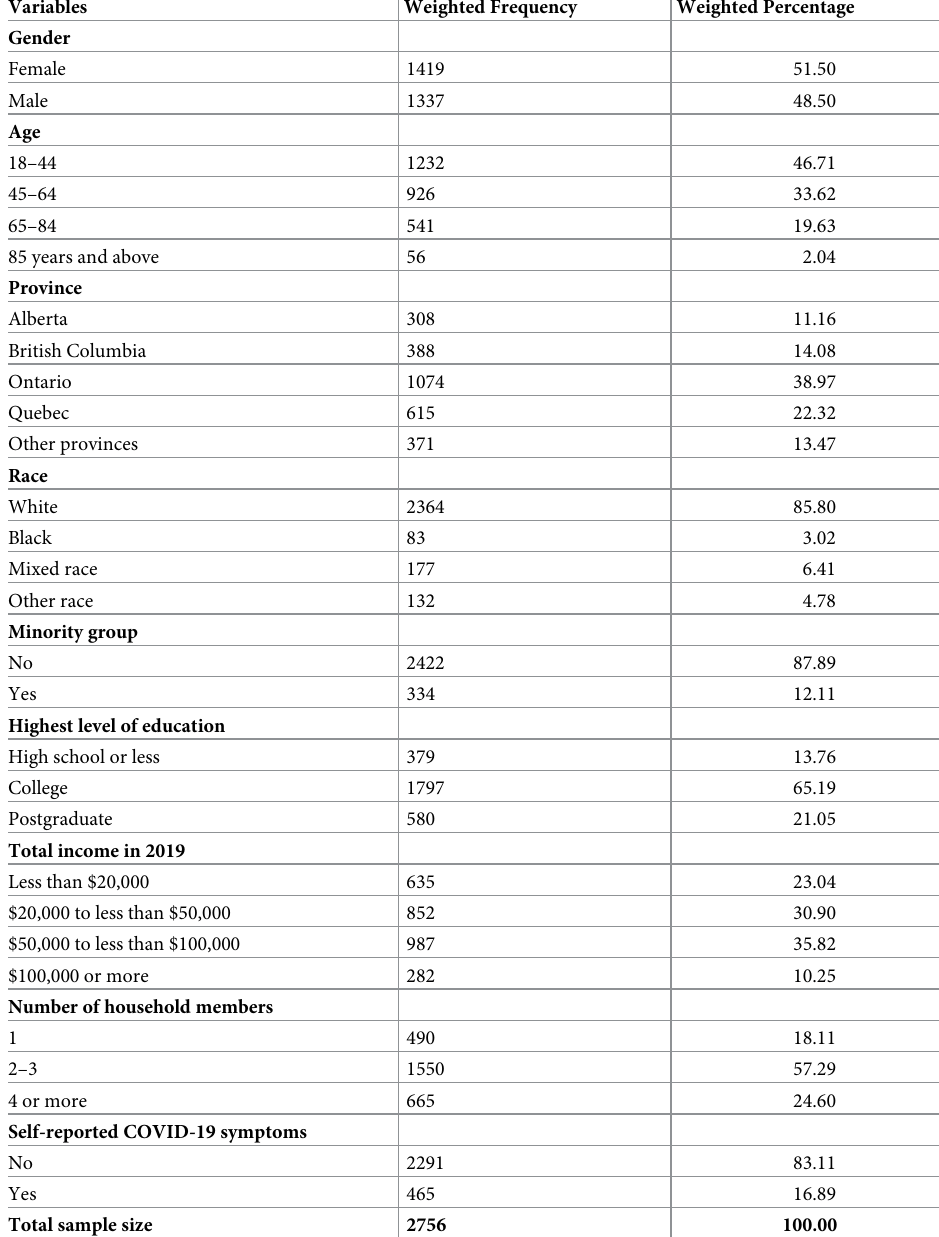
Table 1. Descriptive statistics on socioeconomic and demographic characteristics of